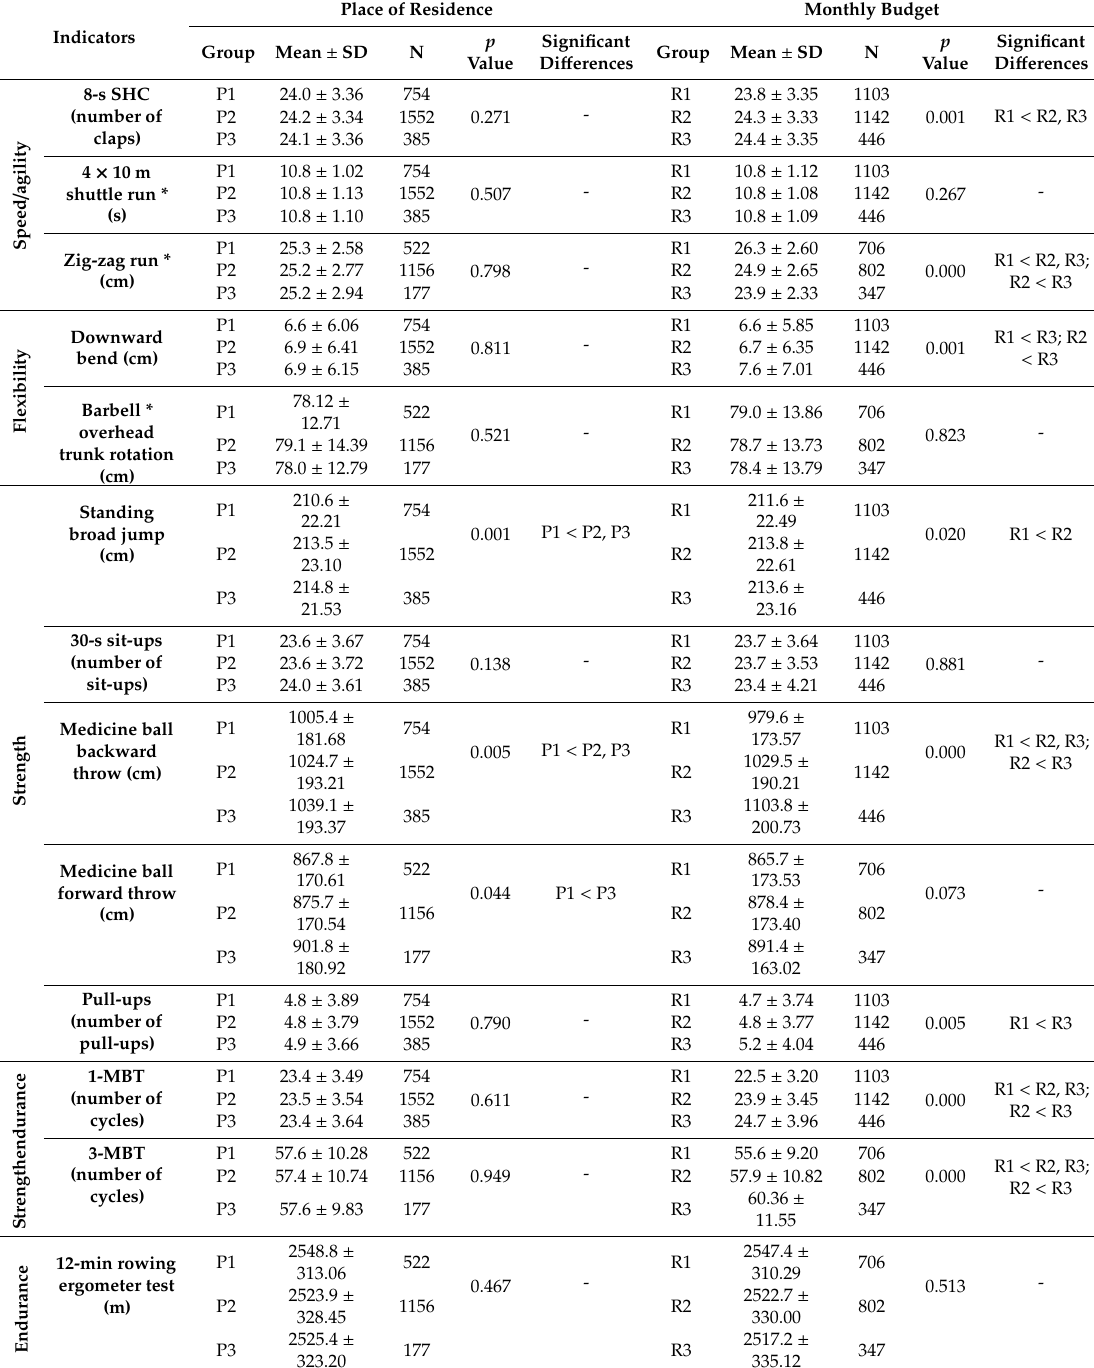
Table 3. Place of residence and students’ monthly budget vs. motor